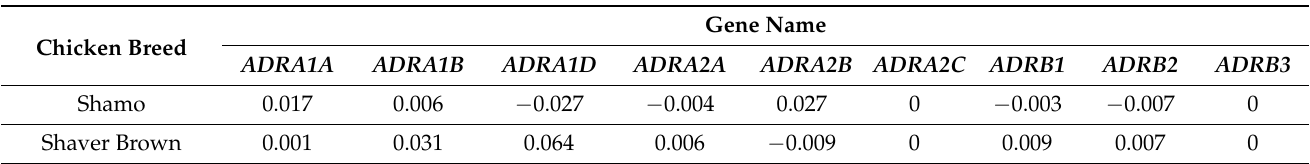
Table 5. Index of nucleotide differentiation ( N ST ) analysis for the nine adrenergic receptor (ADR) genes between the two chicken